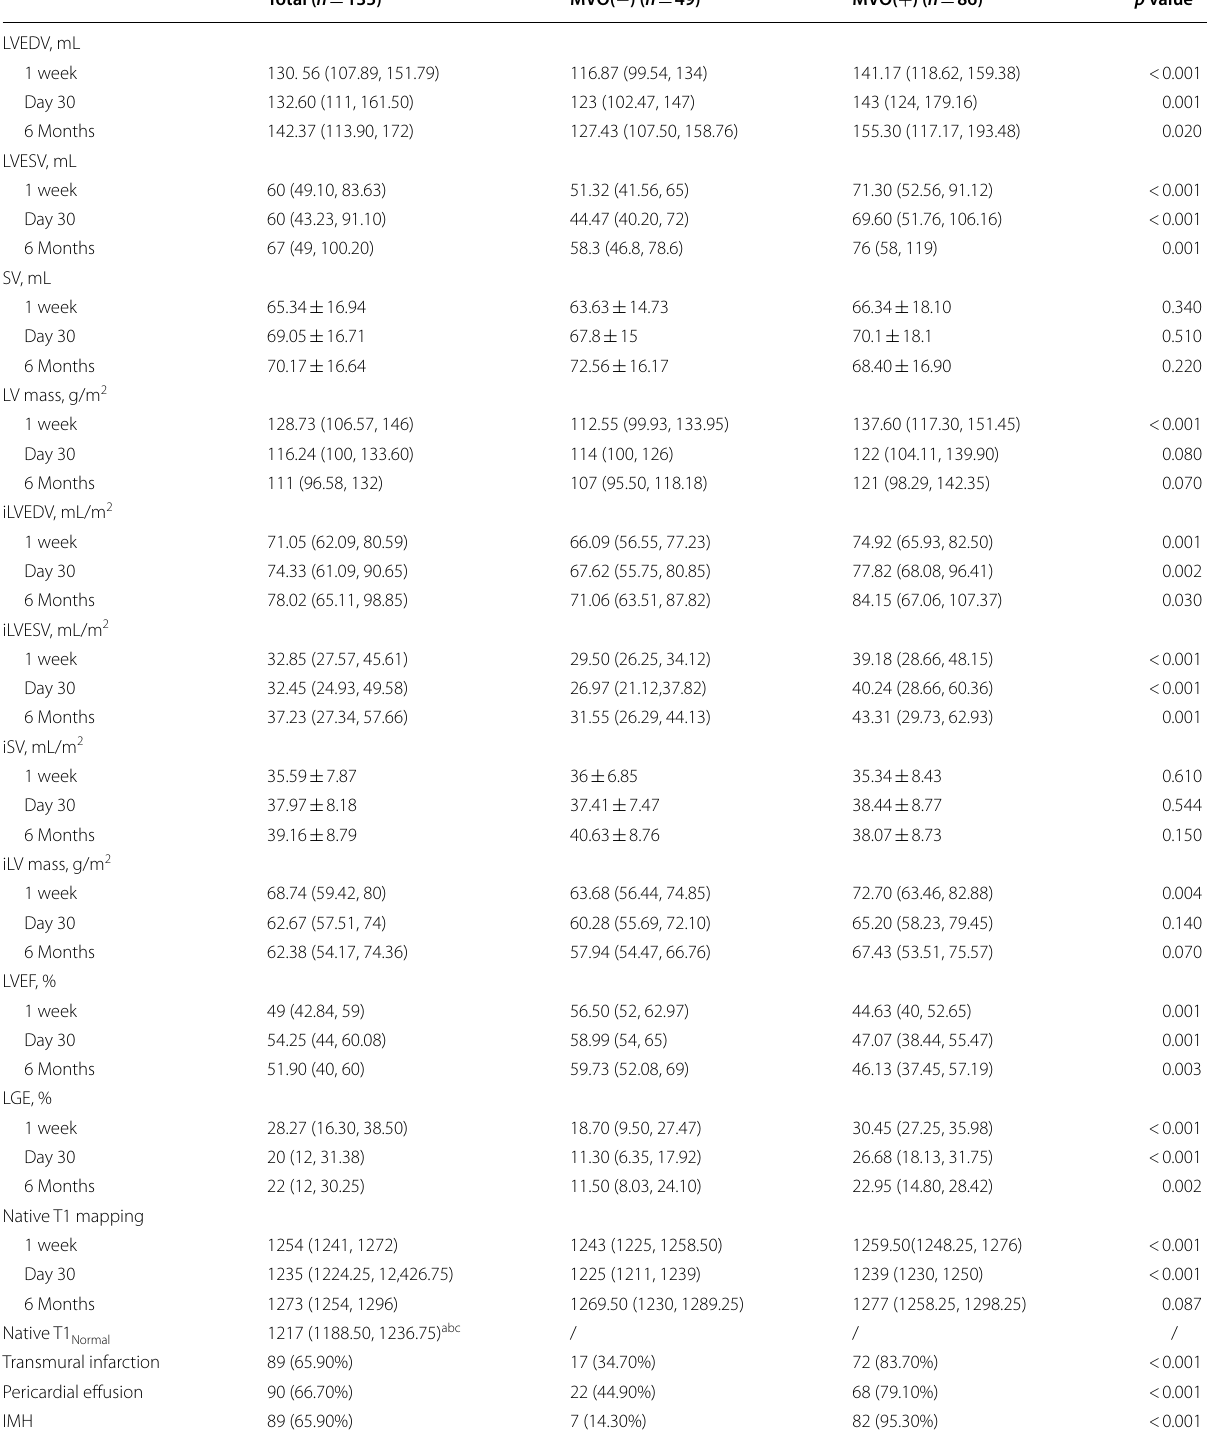
Numbers are given as median (inter-quartile ranges) or mean comparison of patients with MVO and without